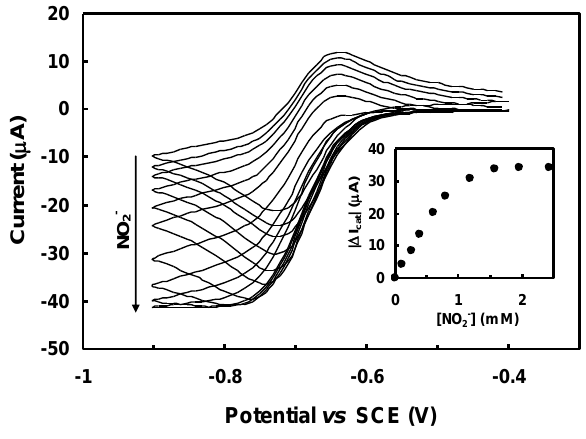
Figure 2. Cyclic voltammograms recorded with a Nafion/c c NiR/methyl viologen/GCE biosensor in the absence of nitrite and in the presence of various nitrite concentrations; adapted from [30]. Inset: corresponding calibration